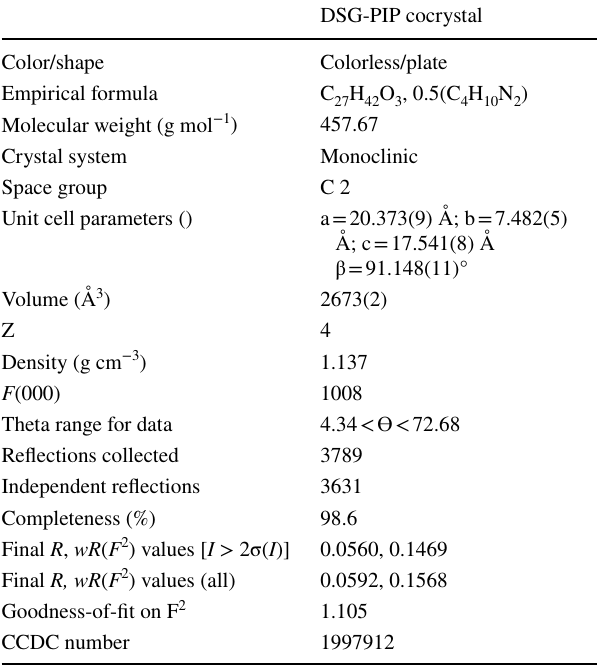
Table 1 Crystal parameters of cocrystal of